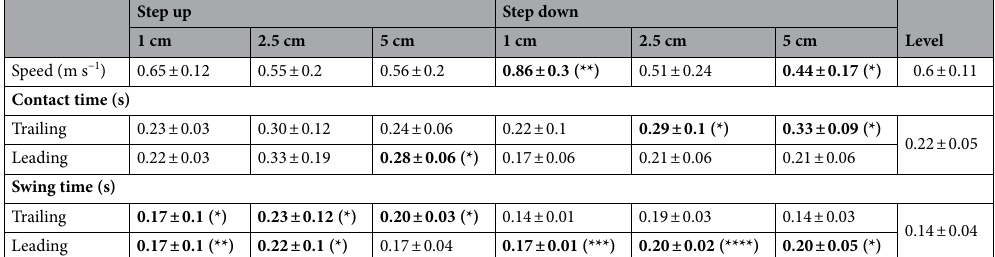
Table 1. Spatiotemporal parameters. Bold marked mean values indicate significant differences related to level locomotion. Significance codes: ‘****’ (p < 0.0001); ‘***’ (p < 0.001); ‘**’ (p < 0.01); ‘*’ (p <